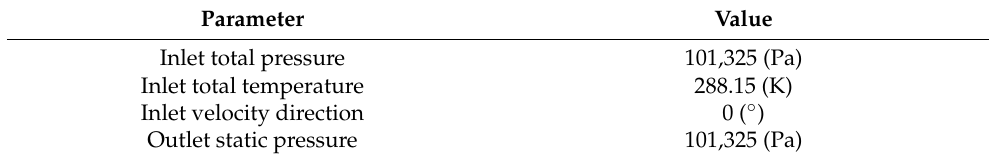
Table 2. Boundary conditions.